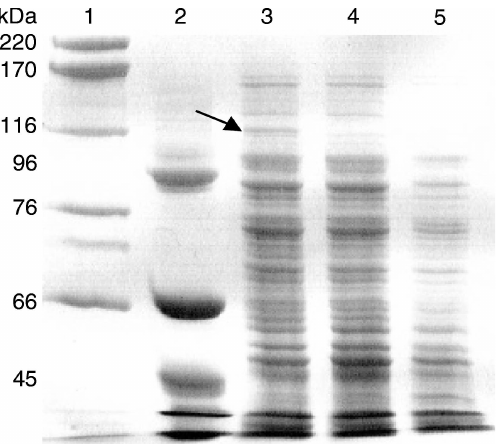
Figure 1. SDS-PAGE patterns of proteins in the soluble fractions ex- tractedfrom recombinantcellsof Escherichia coli BL21(DE3)pLysS. Arrow indicates heterologously expressed disaggregatase protein based on molecular mass. Lane 1, molecular mass marker (high mo- lecular mass); Lane 2, molecular mass marker (low molecular mass); Lane 3, soluble fractions of induced cells containing the expression plasmid (pET-39b(+)- dag ); Lane 4, soluble fractions of uninduced cells containing the expression plasmid; and Lane 5, soluble fractions of induced cells containing the expression vector (pET-39b(+)).